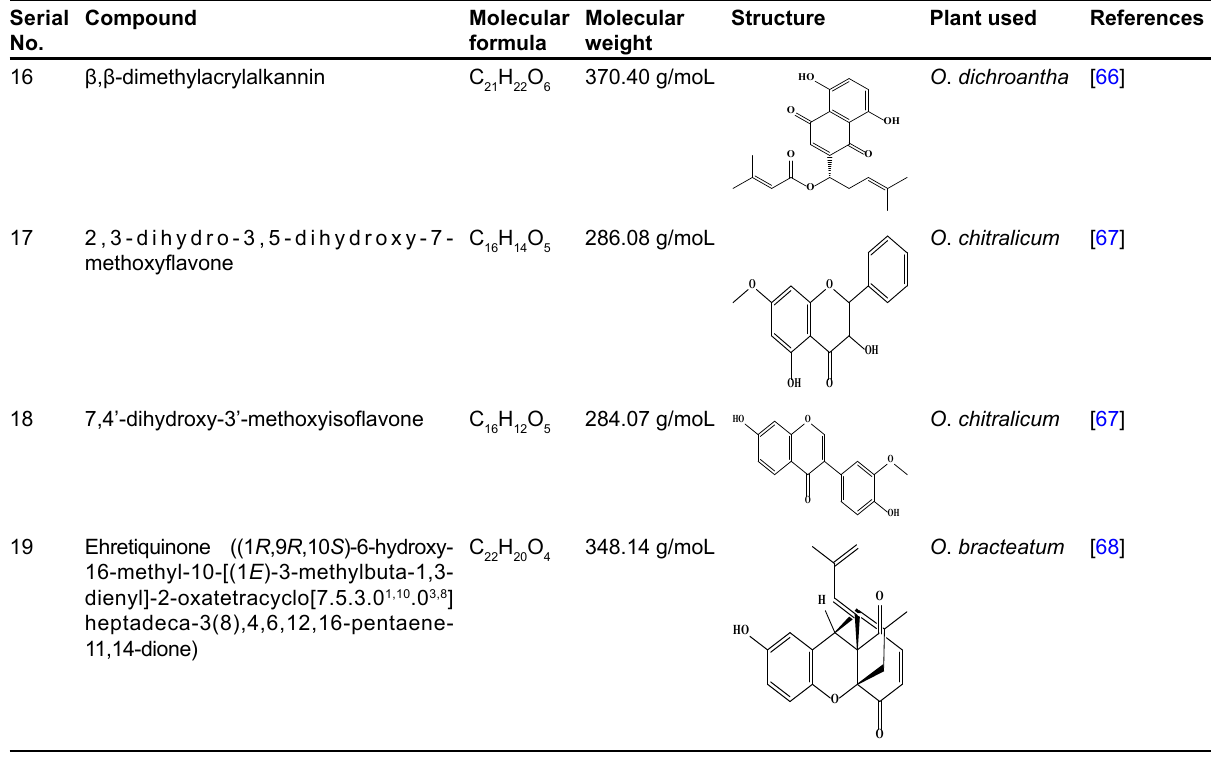
Table 1. Phytoconstituents procured from genus O . ( continued ) Serial No.